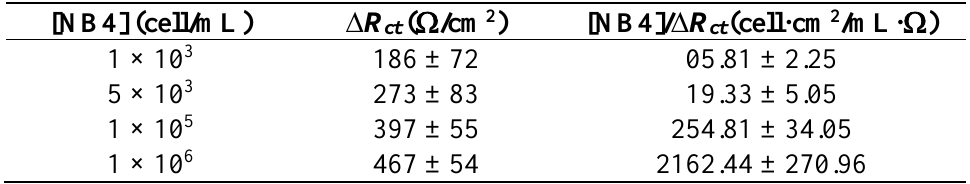
Table 1. The electron transfer resistance of ArtinM–NB4 interaction.